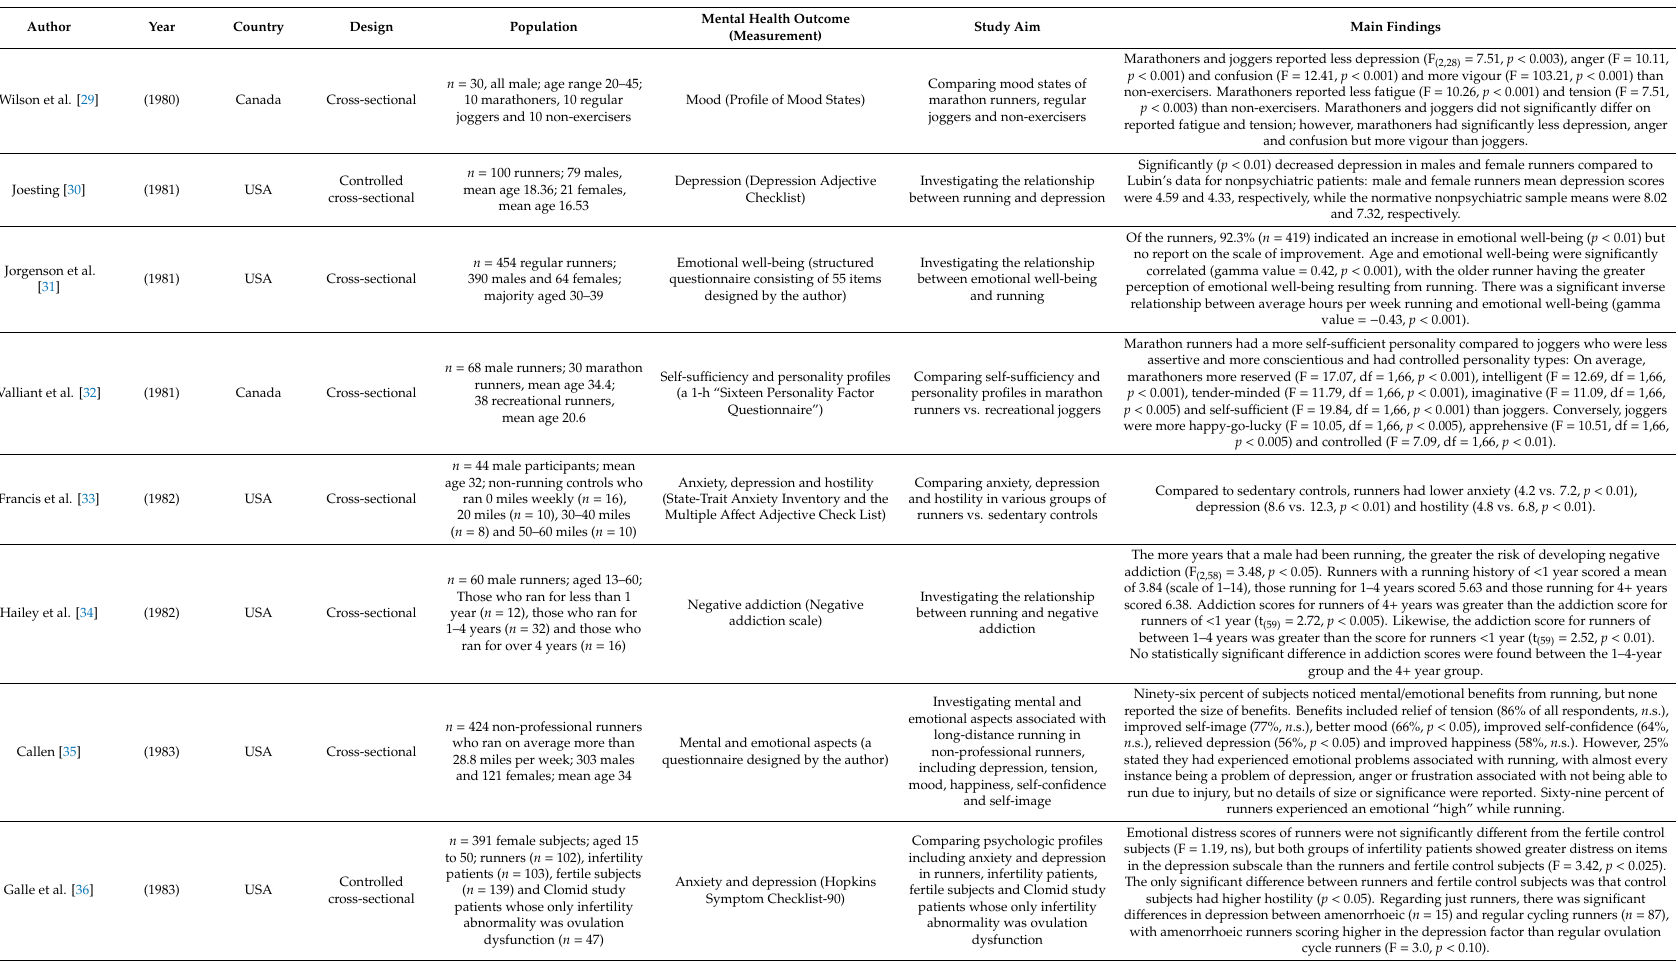
Table 2. Summary of data extraction from the 47 cross-sectional